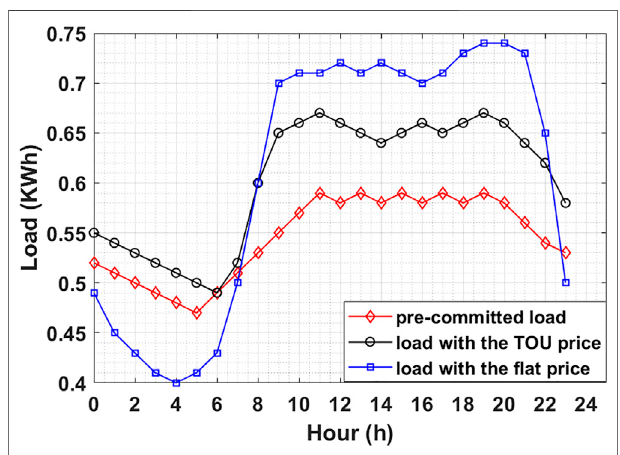
FIGURE 3 | Comparison of load between the fl at price and TOU price.